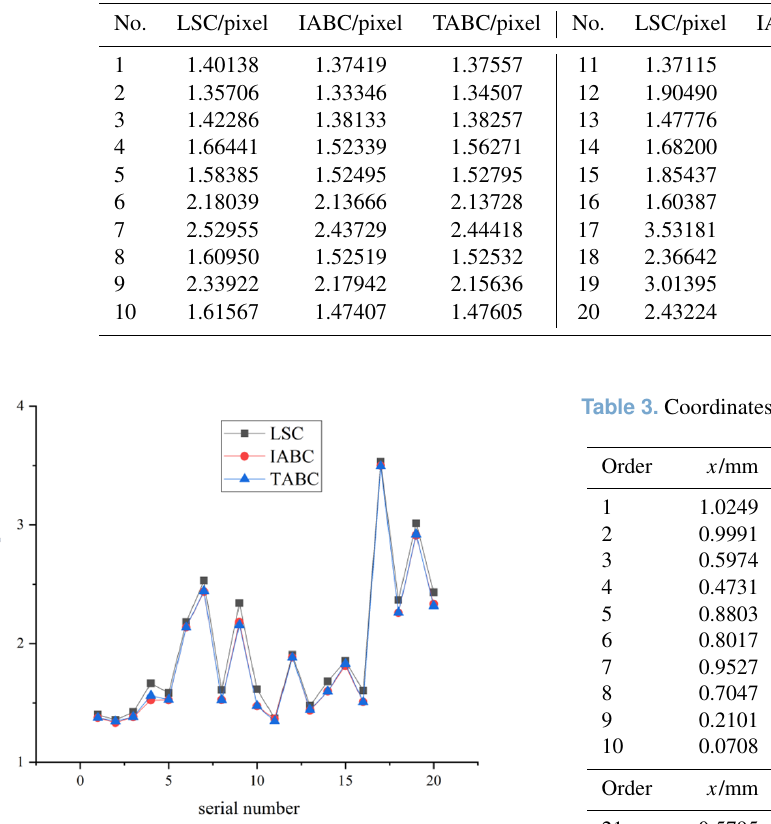
Table 2. Measured dimensions.